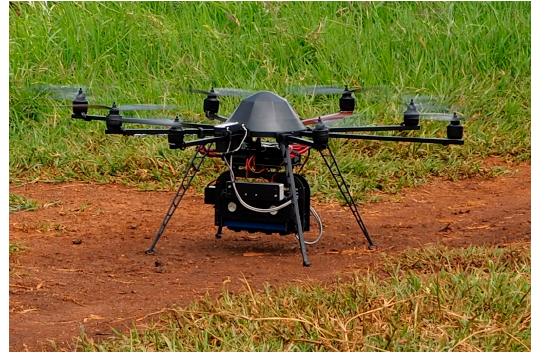
Figure 3. Mikrokopter OktoXL 6S12 unmanned aerial platform equipped with the micro-MCA12 Tetracam multispectral sensor, showing the placement of the Incident Light Sensor (ILS) module with white diffusor plate connected by a fiber optic cable to the top of the UAV facing upwards while the other 11 multispectral sensors are positioned on a dual axis gimbal camera platform for zenithal/nadir image capture. The RGB (Red-Green-Blue) and TIR (thermal infrared) cameras were alternately mounted on the same gimbaled platform for image capture.